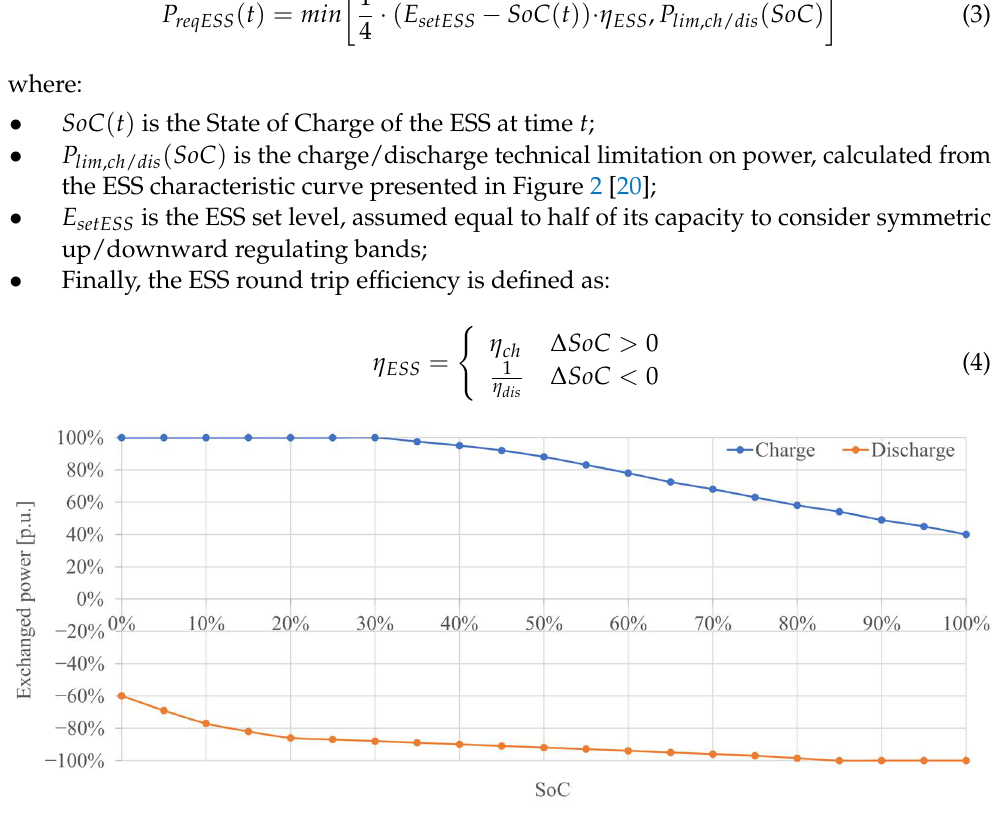
Figure 2. Maximum power exchangeable by the ESS, as a function of